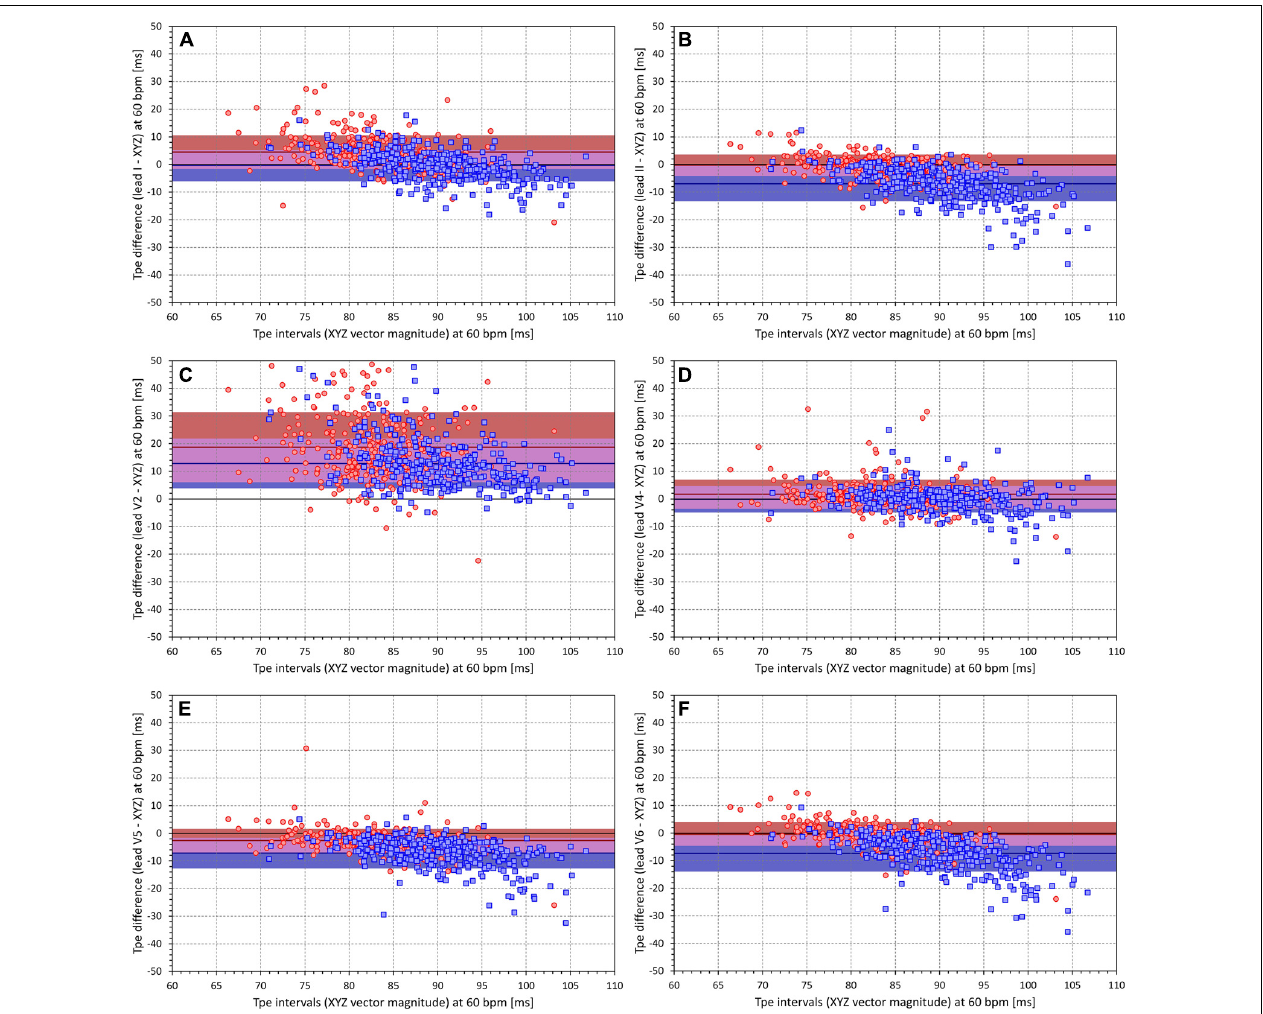
FIGURE 9 | All panels show scatter diagrams between the individual Tpe intervals measured in the XYZ vector magnitude and the corresponding differences between the Tpe intervals measured in different electrocardiogram (ECG) leads and the Tpe intervals measured in XYZ vector magnitude. All the panels show the Tpe values (and their differences) regression projected to the heart rate of 60 bpm. The different panels correspond to the comparison of Tpe measurements made in different ECG leads [ (A) lead I, (B) lead II, (C) lead V2, (D) lead V4, (E) lead V5, (F) lead V6]. In each panel, the red circles and blue squares correspond to female and male subjects, respectively. The solid red and solid blue horizontal lines show the means of the Tpe differences in female and male subjects, respectively. The red- and blue shaded areas are the bands of mean ± standard deviation of the Tpe differences in female and male subjects, respectively. The violet areas are the overlaps between the ± standard deviation bands of both